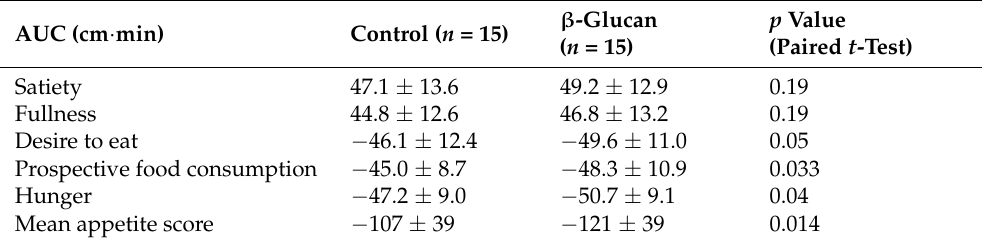
Table 2. Area under the VAS curves (AUC) for satiety, fullness, hunger, food craving, prospective food consumption, and calculated values for mean appetite score during the control and β -glucan periods. Means ± SD.